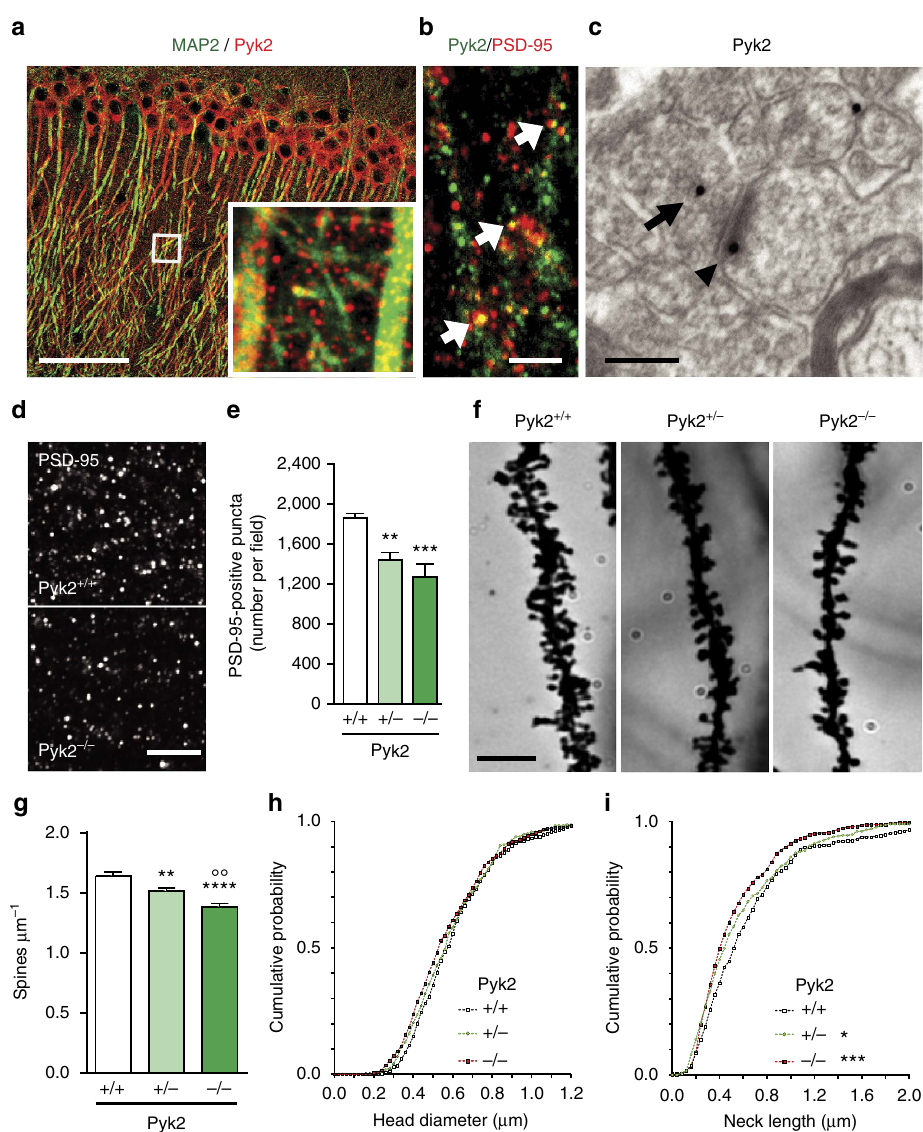
Figure 3 | Pyk2 localization and dendritic spine density and morphology in Pyk2-deficient mice. ( a , b ) Confocal microscopy images of CA1 stratum radiatum immunostained for ( a ) Pyk2 (red) and MAP2 (green; inset, higher magnification of the indicated white box) and for ( b ) Pyk2 (green) and PSD-95 (red; white arrows, double-labelled puncta). Scale bars, 80 m m ( a ) and 3 m m ( b ). ( c ) Electron microscopy in the same region showing of Pyk2 immunoreactive gold particles in a presynaptic terminal (arrow) and a PSD (arrowhead). Scale bar, 0.2 m m. ( d ) Immunofluorescence PSD-95-positive puncta in the CA1 stratum radiatum from Pyk2 þ / þ and Pyk2 (cid:2) / (cid:2) mice. Scale bar, 5 m m. ( e ) Quantification of puncta as in d . Data are means þ s.e.m. (7–10 mice per genotype, three quantified sections per mouse). One-way ANOVA F (2,21) ¼ 10.23, P ¼ 0.0008. Holm-Sidak’s multiple comparisons test versus þ / þ , ** P o 0.01, *** P o 0.001. ( f ) Golgi-Cox-stained apical dendrites of CA1 stratum radiatum pyramidal neuron from Pyk2 þ / þ , Pyk2 þ / (cid:2) and Pyk2 (cid:2) / (cid:2) mice. Scale bar, 3 m m. ( g ) Quantification of spine density in dendrites as in f , three–four animals per genotype, one-way ANOVA, F (2,146) ¼ 14.95, P o 10 (cid:2) 4 ( n ¼ 47–54 dendrites per group), post hoc analysis with Holm-Sidak’s multiple comparisons test versus þ / þ , ** P o 0.01, **** P o 10 (cid:2) 4 and (cid:2) / (cid:2) versus (cid:2) / þ , (cid:2)(cid:2) P o 0.01. ( h , i ) Cumulative probability of spine head diameter ( h , n ¼ 80) and spine neck length ( i , n ¼ 115) in B 60 dendrites from three–four animals per genotype. Distributions were compared with the Kolmogorov–Smirnov test: spine head diameter no significant difference, neck length þ / þ versus þ / (cid:2) , D ¼ 0.108, P ¼ 0.04, þ / þ versus (cid:2) / (cid:2) , D ¼ 0.154, P ¼ 0.0005. In e , g , data are means þ s.e.m. All mice were 3–4-month AAV-GFP had no effect (Fig. 4a). In the NOL test, AAV-GFP- AAV-GFP-injected mice (Fig. 4e,f). Altogether these results show injected mice showed increased preference for the object placed that local deletion of Pyk2 in CA1 of adult mice recapitulates at the new location, whereas AAV-Cre-injected mice did not behavioural and morphological deficits observed in Pyk2 þ / (cid:2) and Pyk2 (cid:2) / (cid:2) mice, ruling out a developmental effect in the (Fig. 4b). We analysed spine density in CA1 apical dendrites and phenotype of Pyk2 mutant mice. found it was significantly reduced in AAV-Cre-injected mice as compared to AAV-GFP-injected mice (Fig. 4c,d). We also Pyk2 is needed for NMDA-induced PSD-95 recruitment in spines . quantified a reduced number of PSD-95-positive puncta in CA1 stratum radiatum of AAV-Cre-injected mice as compared to PSD-95 undergoes rapid activity-dependent relocalization 24 .